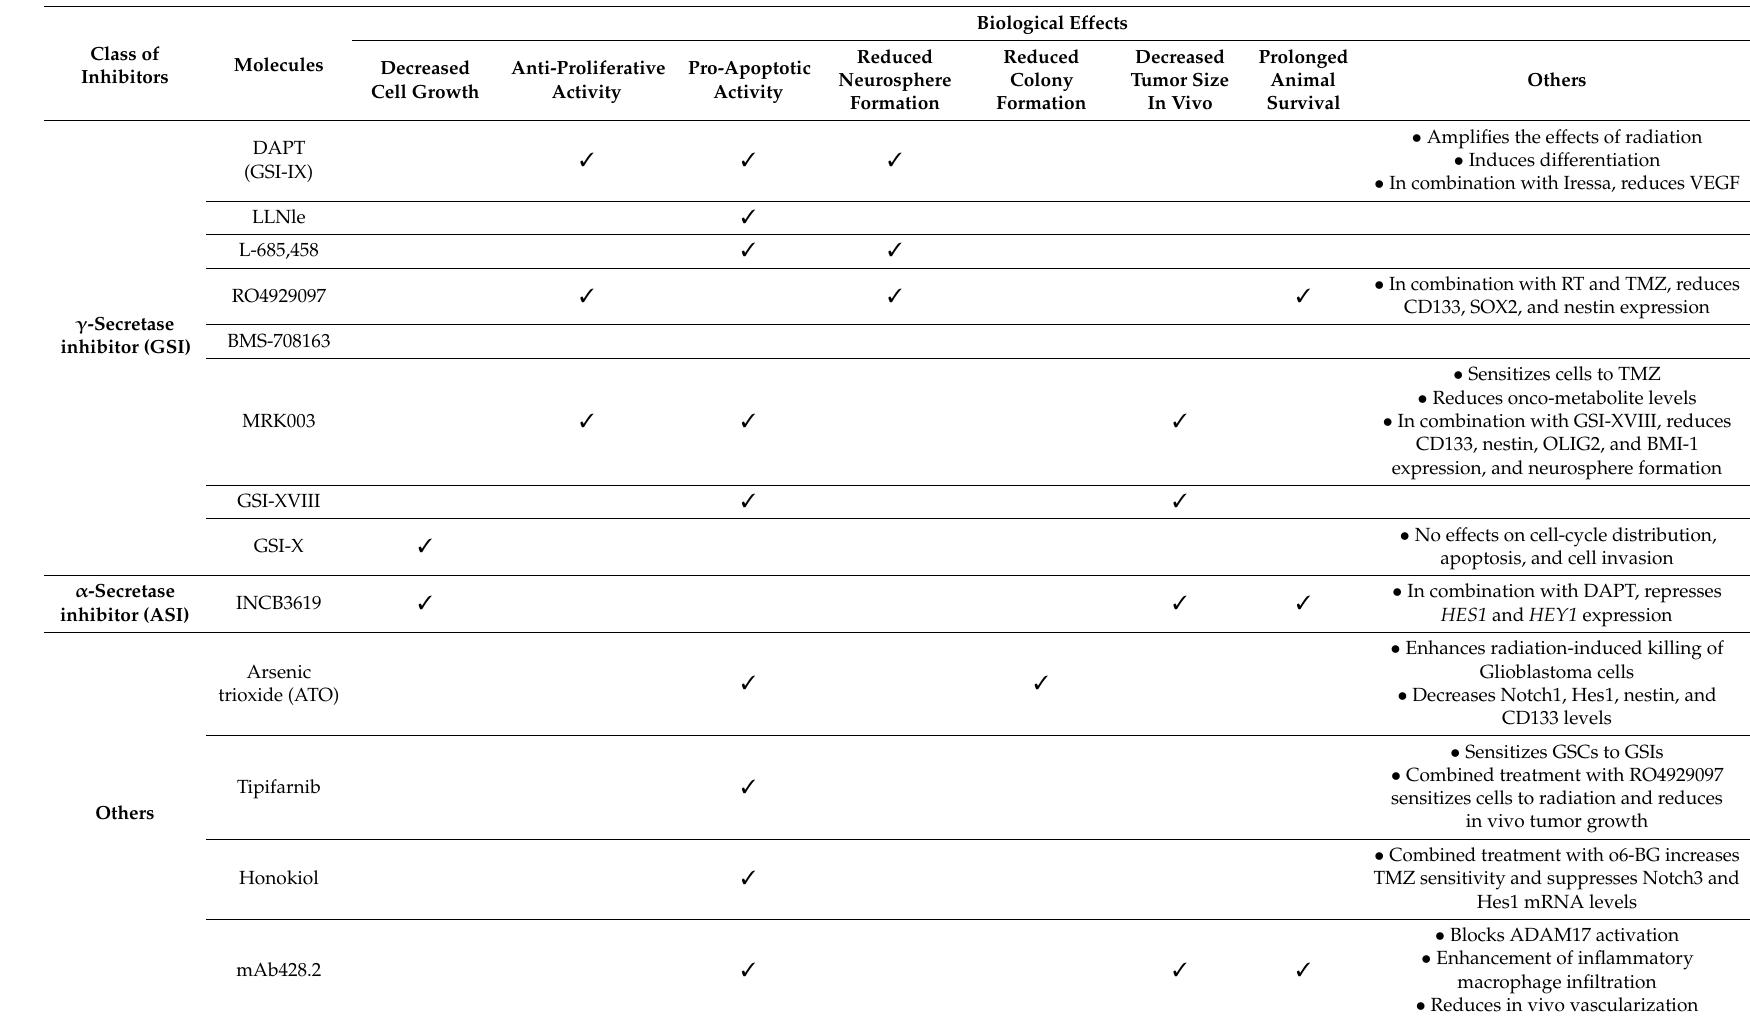
Table 2. Therapeutic approaches against Notch signaling in